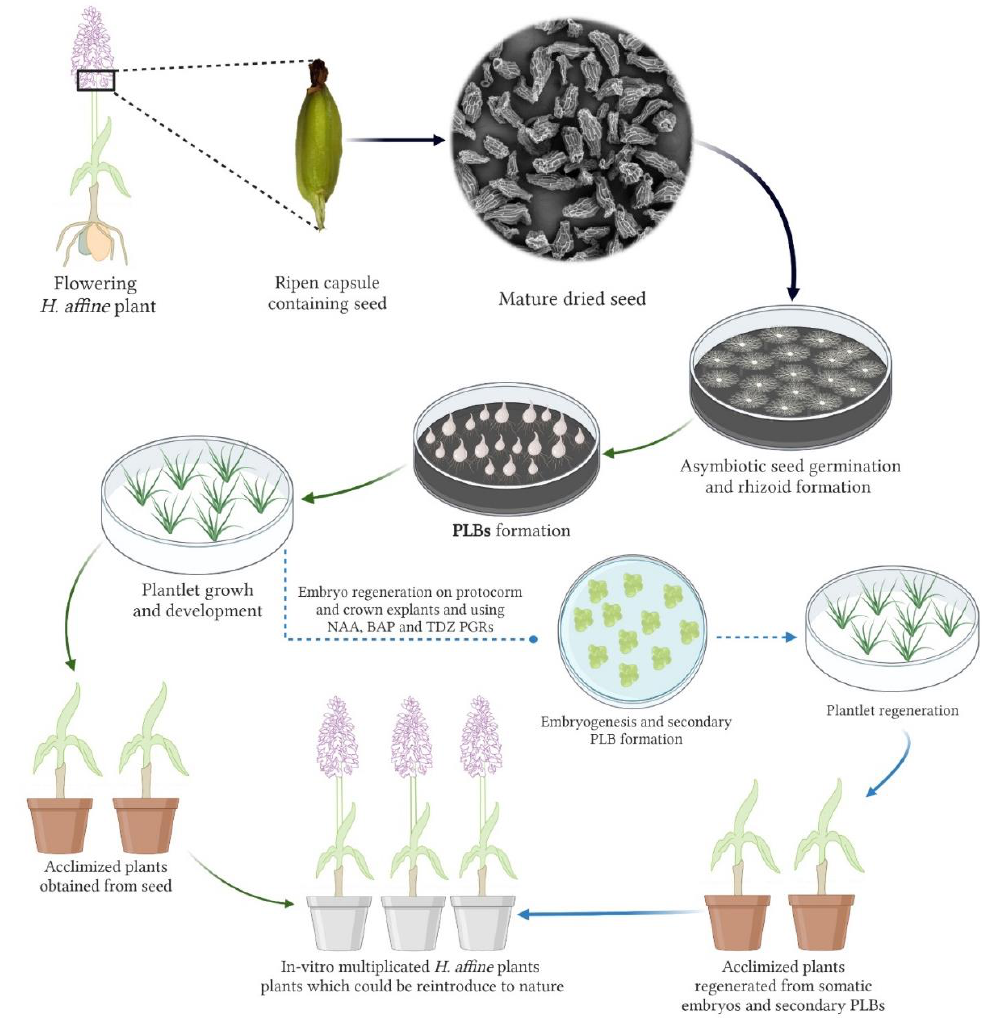
Figure 5. Flow diagram showing the strategy for in vitro large-scale micropropagation of H. affine (Boiss.) Schltr. via asymbiotic seed germination and somatic embryogenesis. Created with BioRender.com.